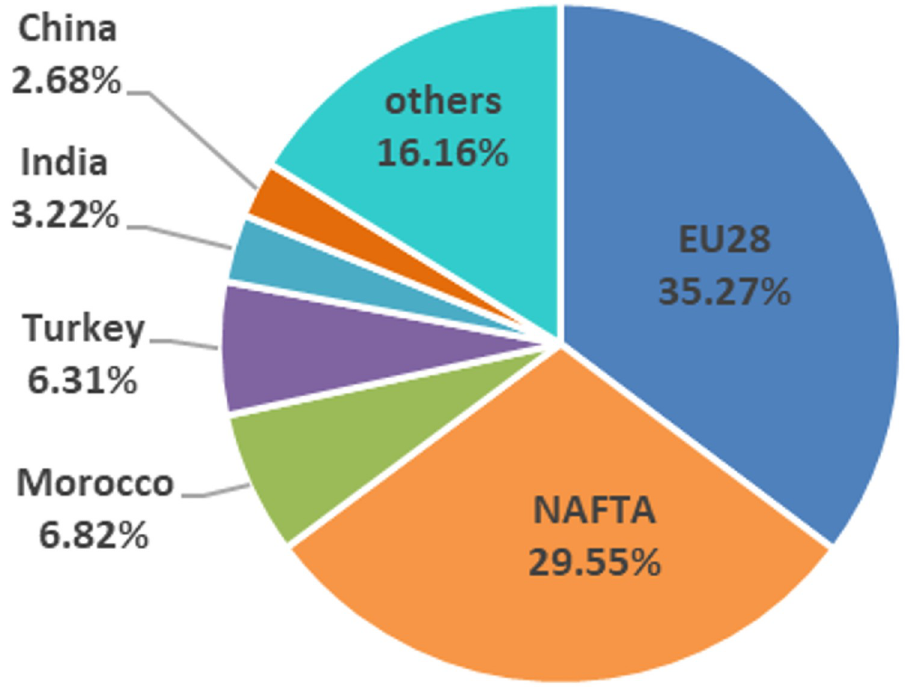
Fig 3. Main tomatoes exporting regional commercial areas and countries